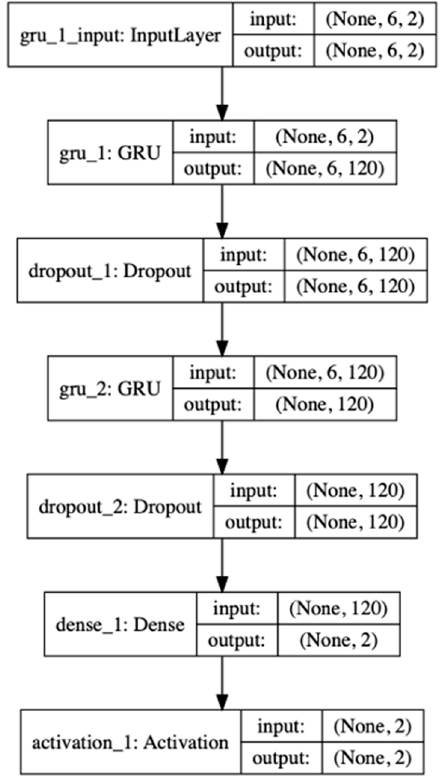
Figure 14. Plot of all parameters setting of GRU recurrent neural network model.